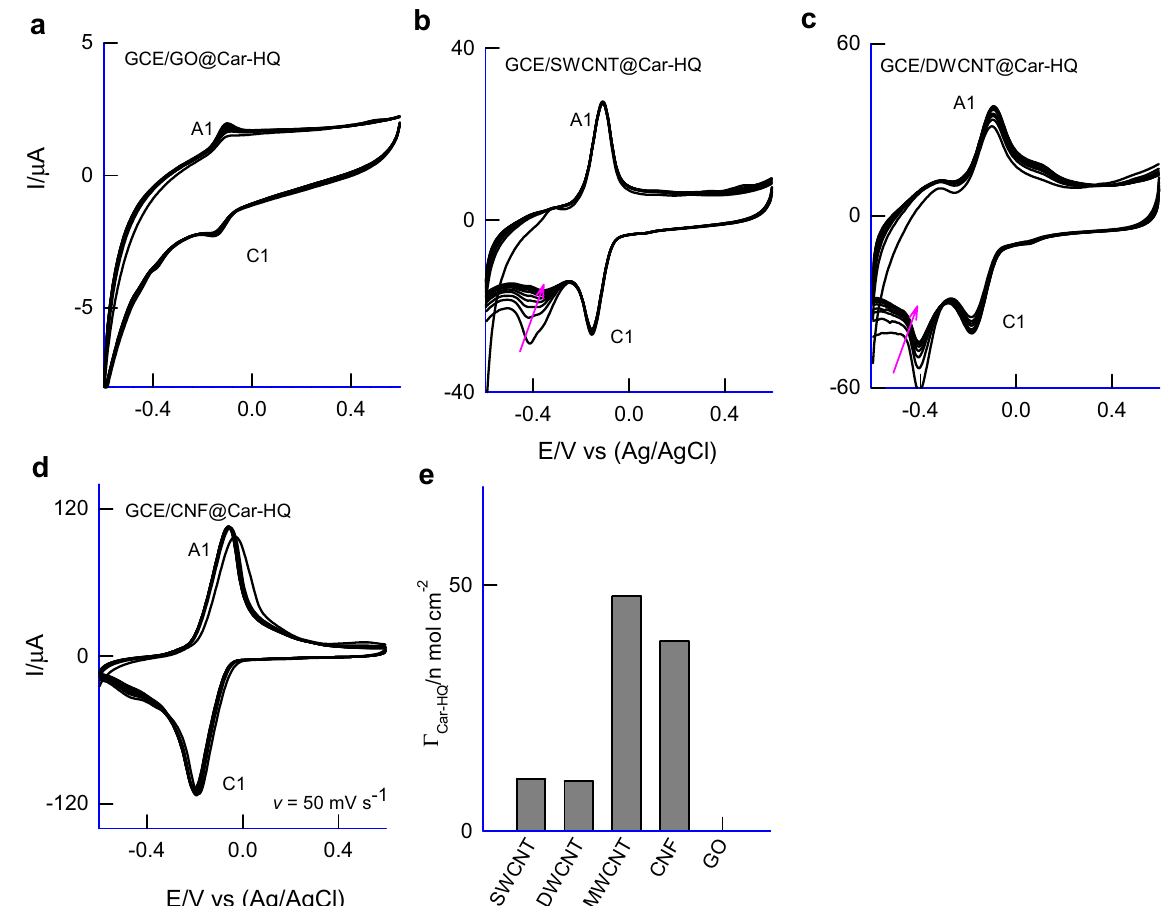
Figure 5. Comparative CV responses of Car-HQ modified various carbon materials; ( a ) GCE/GO@Car-HQ, ( b ) GCE/SWCNT@Car-HQ, ( c ) GCE/DWCNT@Car-HQ, ( d ) GCE/CNF@Car-HQ in pH 7 phosphate buffer solution at v = 50 mV s −1 . ( e ) A bar diagram of surface excess value versus various carbon material modified Car-HQ